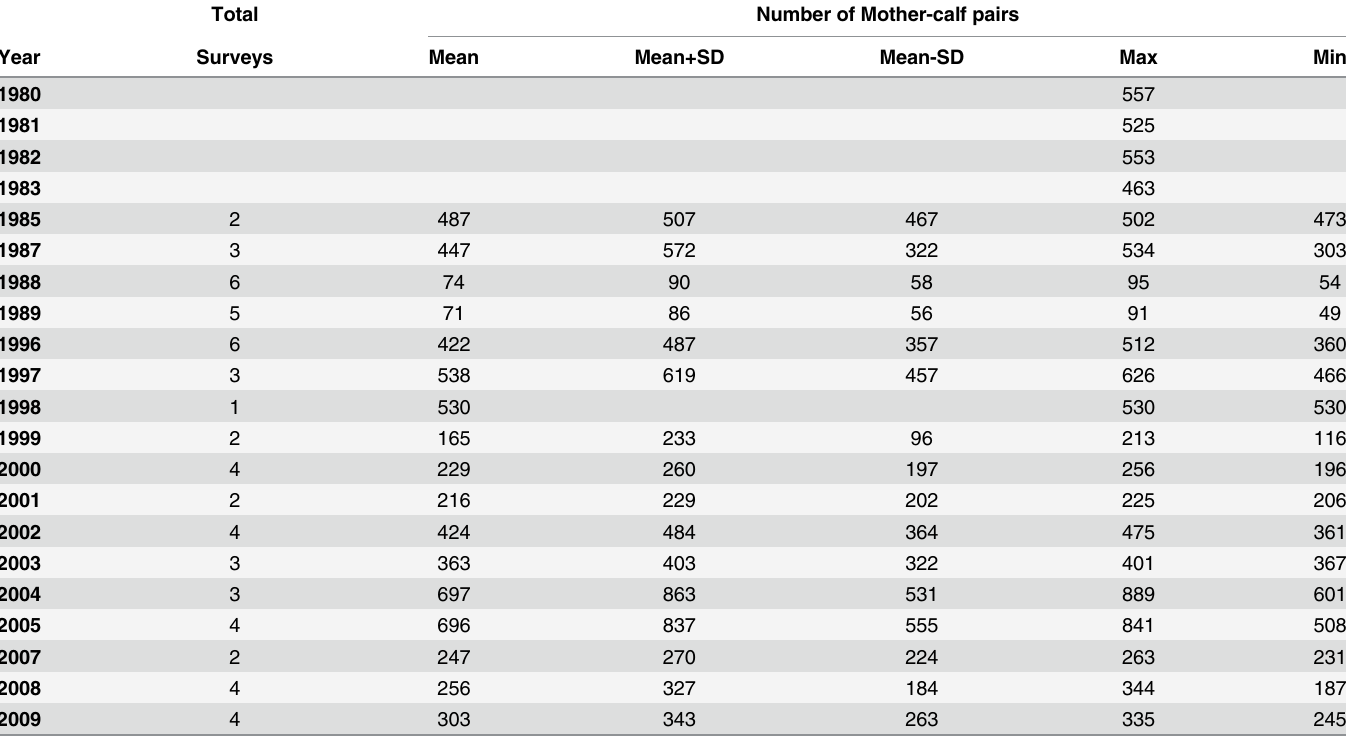
During each survey, the boat followed the predetermined survey transect (Fig 1b) using visual landmarks and a hand-held GPS while traveling at a speed of 11 km/h. As gray whales typically travel at 6 km/h [28], this survey speed limited the opportunity for whales to move ahead of the boat and be counted more than once. At the same time, this speed was not fast enough to miss whales that were below the surface, given the typical dive time of 1.0 to 2.6 min [29]. To avoid Table 2. Long-term dataset and basic statistic of gray whale survey counts conducted during the month of February at OLL. Mean: sum of the total number of whales counted during all the surveys conducted during February divided by the total number of surveys conducted in that month (total whales/ total surveys); SD: standard deviation; Max: survey with the maximum number of mother-calf pairs counted; Min: survey with the minimum number of mother- calf pairs